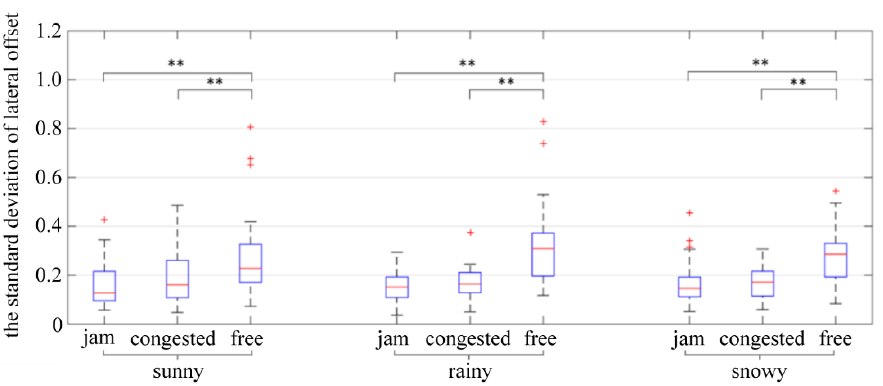
Figure 14. The standard deviation of lateral offset. ** indicates the variable was statistically significant at 0.05 level. + indicates outlier.